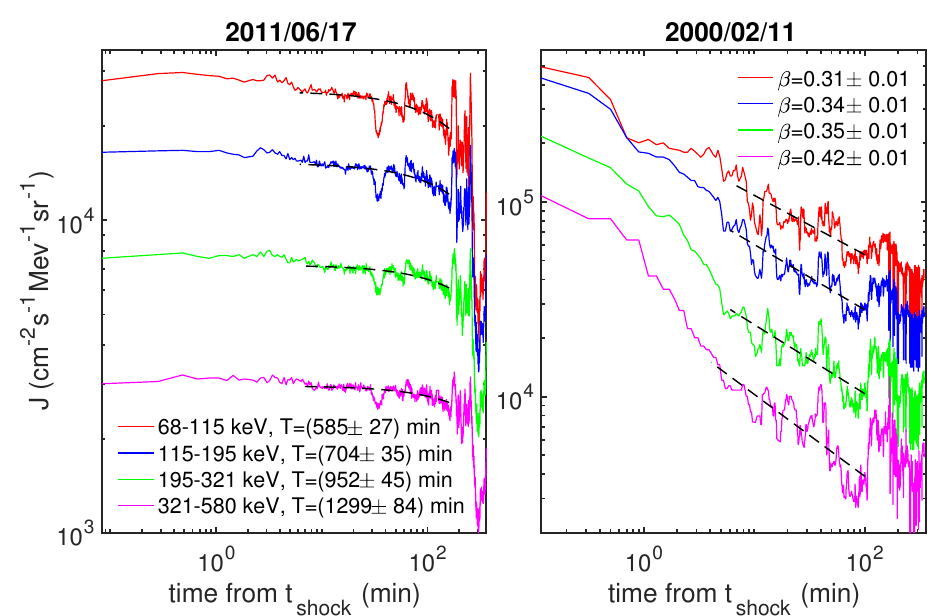
Figure 2. Plot in log–log axes of the ion energy fluxes in four different channels (as indicated in the figure legend) as a function of the distance from the shock time. For the quasi-parallel shock of the 17 June 2011 ( left panel ) the far upstream decay is well fitted by an exponential function J ( t ) ∝ exp ( − t / T ) , while in the quasi-perpendicular shock on 11 February 2011 ( right panel ), the ion fluxes decay as a power-law in the upstream region suggesting superdiffusive transport. The exponential and power − law best fits are reported in the panels together with their best fit